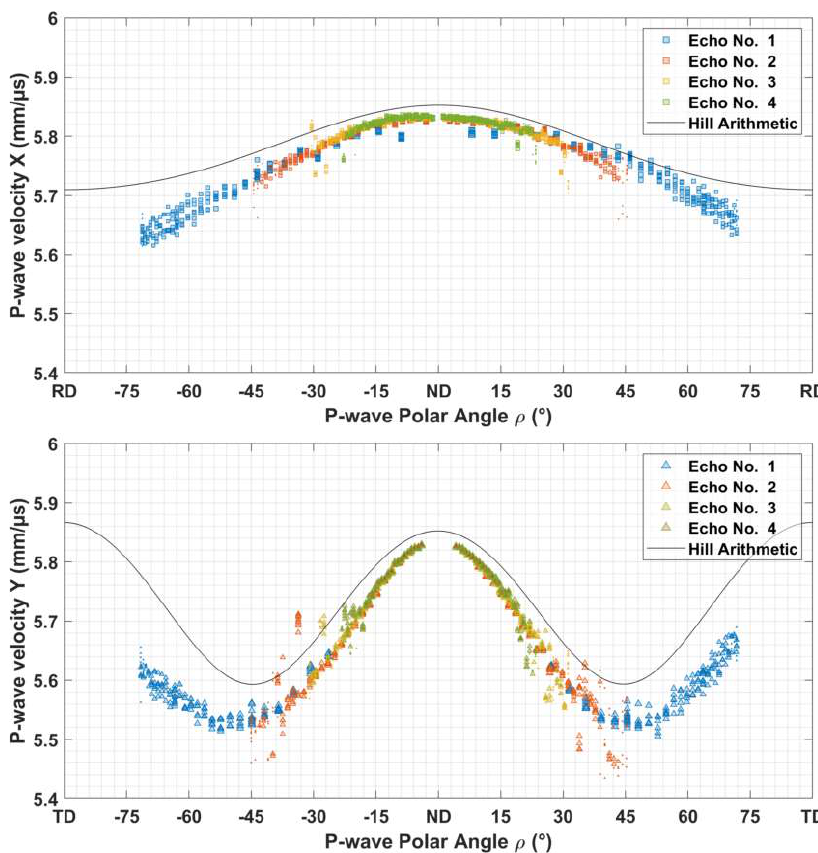
Figure 11. Longitudinal wave velocity as a function of polar angle for azimuthal values of 0° (above) and 90° (below).